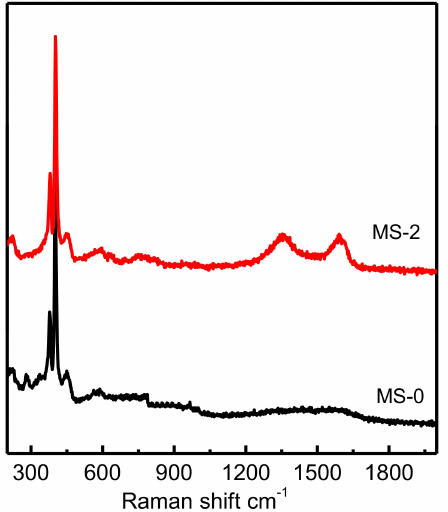
Figure 4. Raman spectra of pure MoS 2 (MS-0) and MoS 2 -G (MS-2).